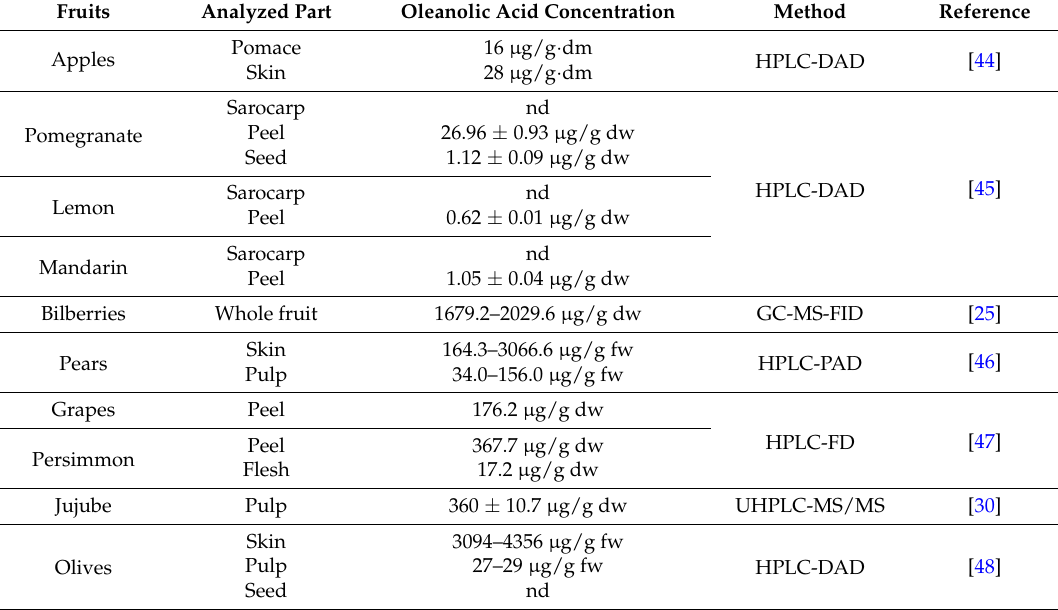
Table 1. Main sources of oleanolic